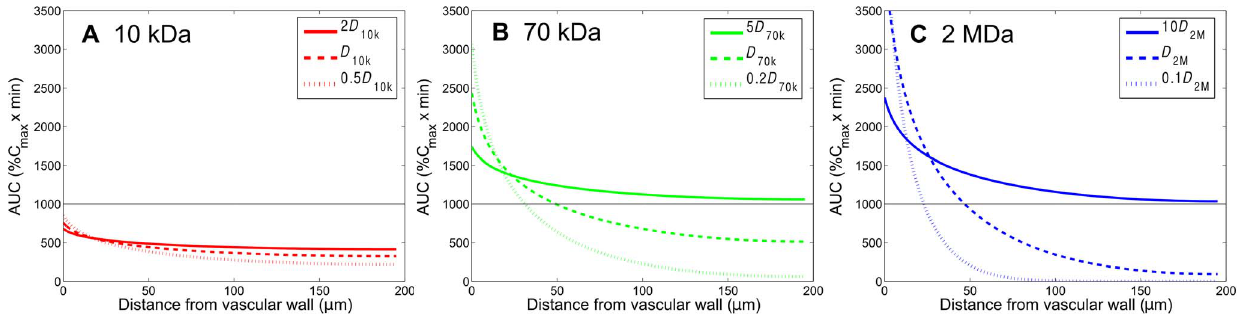
Figure 6. Effect of interstitial diffusivity of carriers on the spatial distribution of accumulative exposure. The effect of interstitial diffusivity of carriers on the spatial distribution of accumulative exposure (in the radial distance, up to 0 : 5% C max ) (MW: 10 kDa, 70 kDa, 2 MDa) in the tumor interstitium. The horizontal lines show the value of AUC equal to 1000 % C max | min .